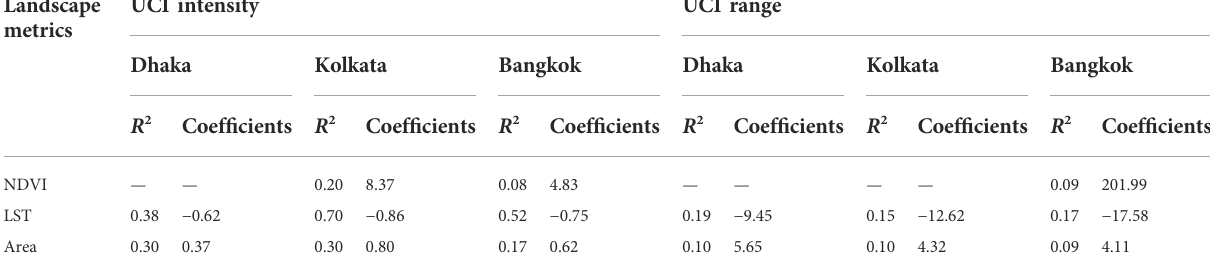
TABLE 7 Regression analysis between the cooling effect and landscape metrics. Landscape